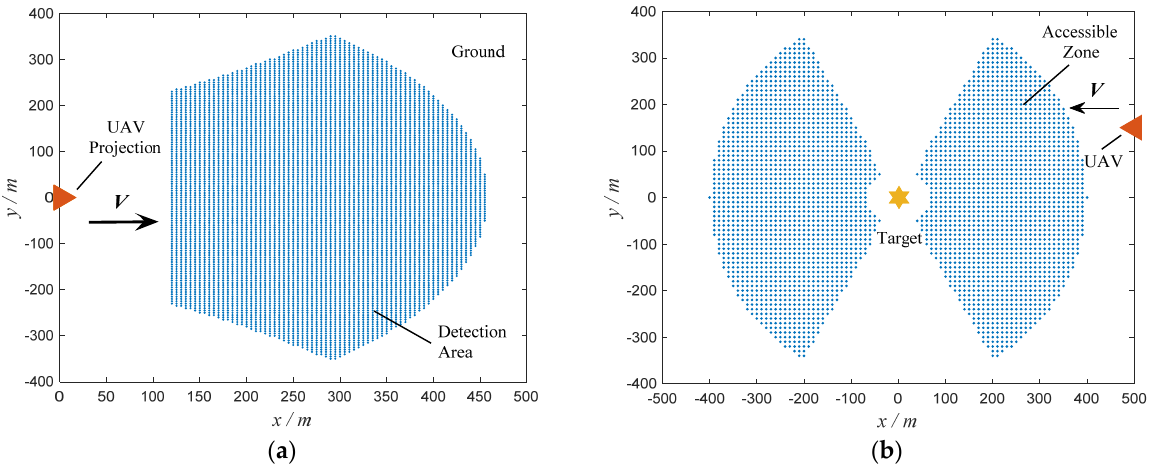
Figure 9. The feasible area of payload: ( a ) the available detection area; ( b ) the available attack zone. Consider a 5 × 5 km mission scenario. The information of known targets and the time window constraints of subtasks randomly generated is shown in Table 4.